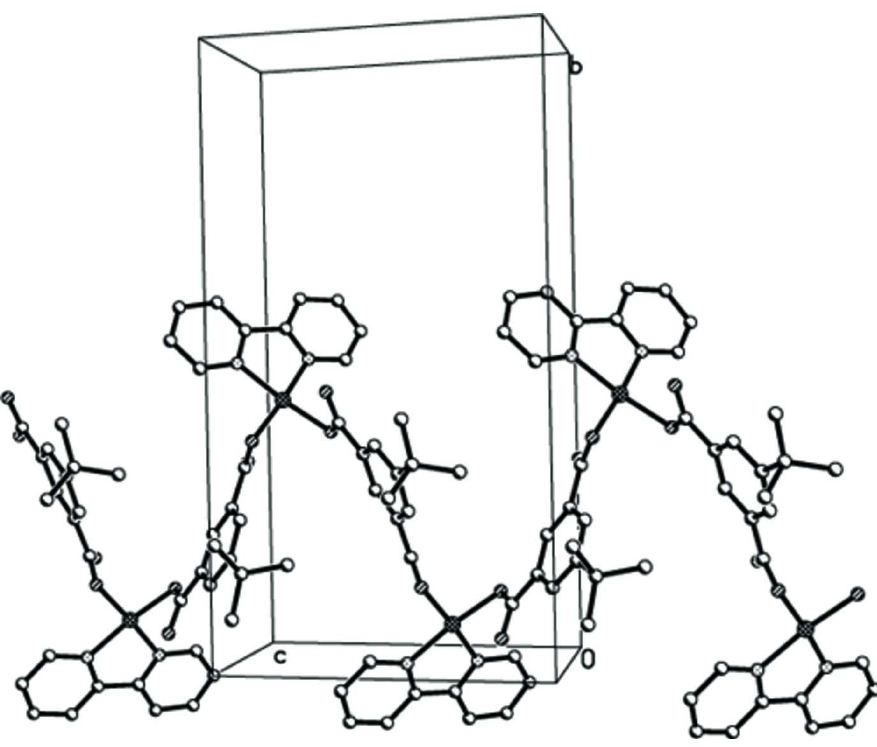
Figure 2 A partial view, along the a axis, of the crystal packing of compound (I) showing the zigzag polymer chain. H atoms have been omitted for